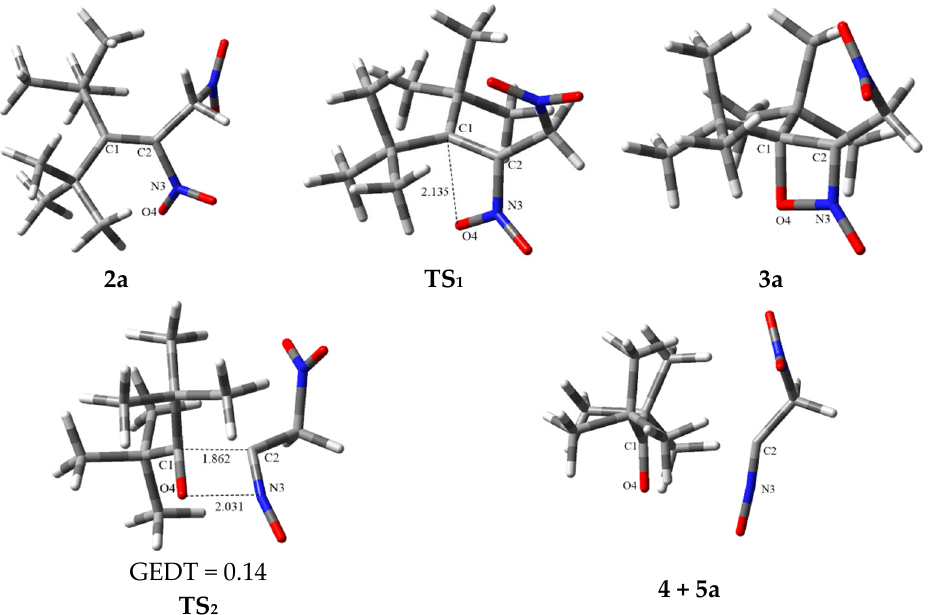
Figure 3. MPWB1K/6-311G(d,p) geometries of the critical structures for formation of 4,4-di-tert-bu- tyl-3-nitromethyl-4H-[1,2]oxazete 2-oxide ( 3a ) and retro-32CA reaction leading to di-tert-butyl ke- tone ( 4 ) and nitrile oxide derivative ( 5a ). Distances are given in angstroms, Å and GEDT in e. 2.3. BET Study of the Formation of 4,4-Di-Tert-Butyl-3-Nitromethyl-4H-[1,2]Oxazete 2-Oxide ( 3a ) and Retro-32CA Reaction Leading to Di-Tert-Butyl Ketone ( 4 ) and Nitrile Oxide Derivative ( 5a )